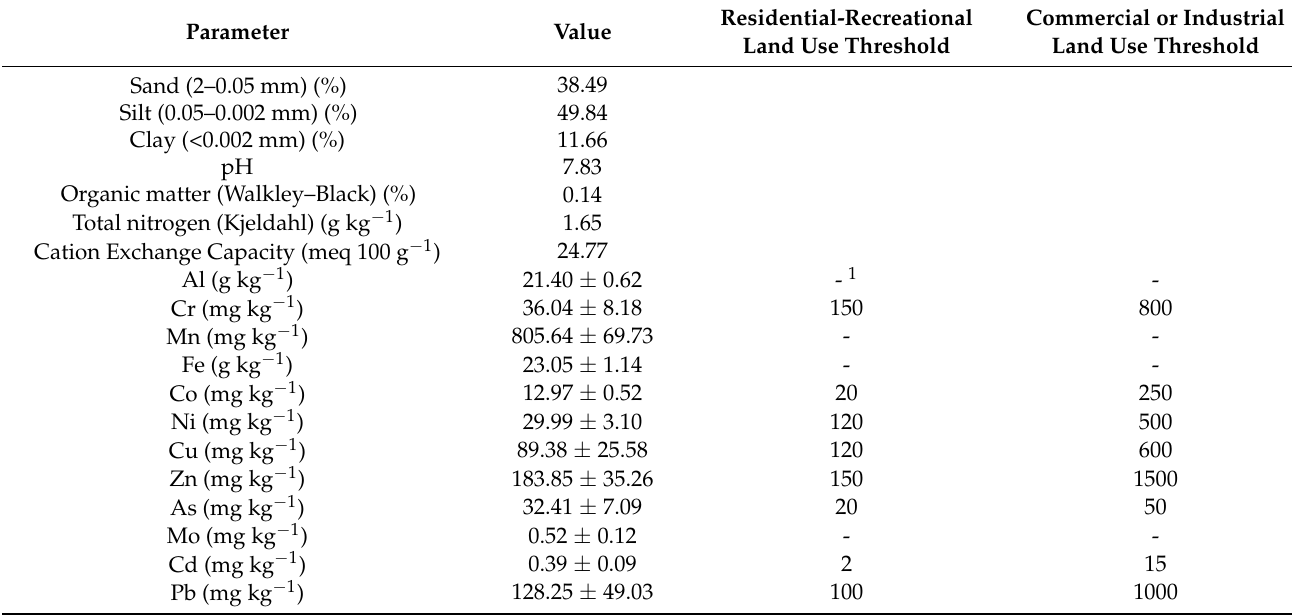
Table 1. Soil characteristics at the experimental site 0–30 cm (March 2017) and soil thresholds for residential/recreational and commercial or industrial use, by Italian norms concerning the remediation of contaminated soils [34]. Parameter Value